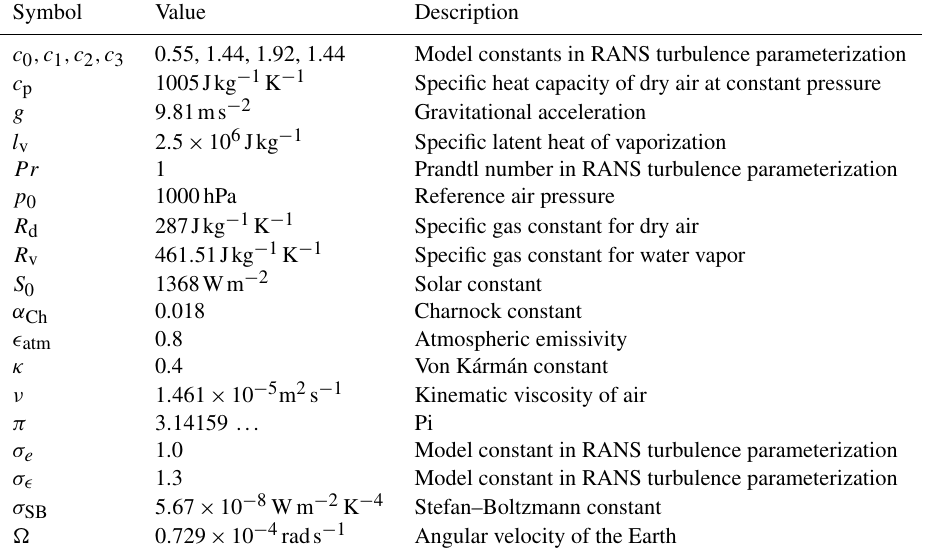
Table 1. List of general model parameters.